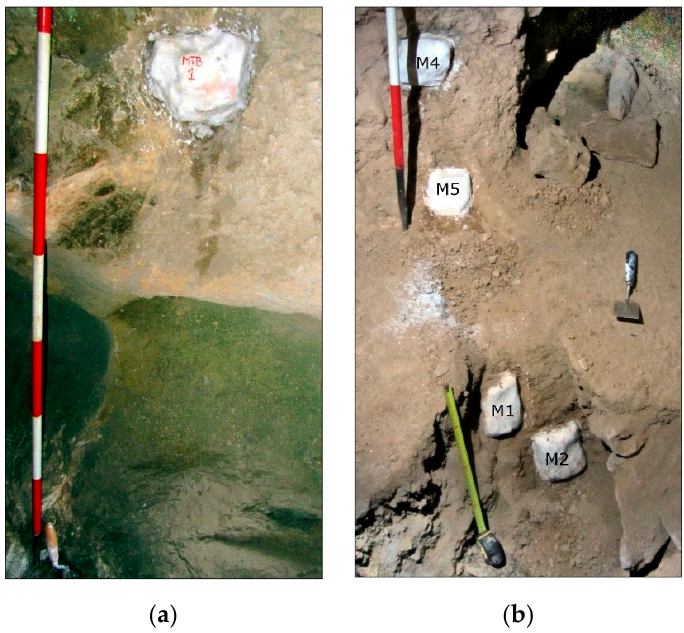
Figure 4. Sampling in the first part ( a ) and in the middle of the cave ( b